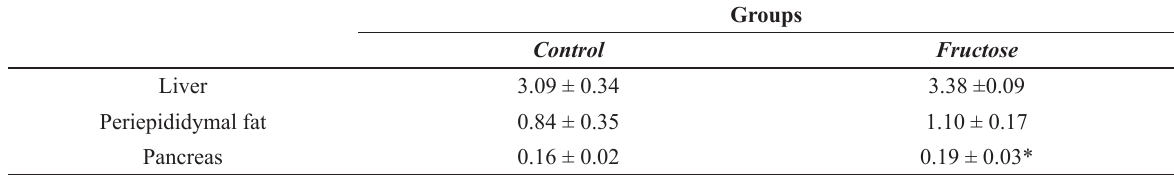
Relative organ weight of control and fructose rats.